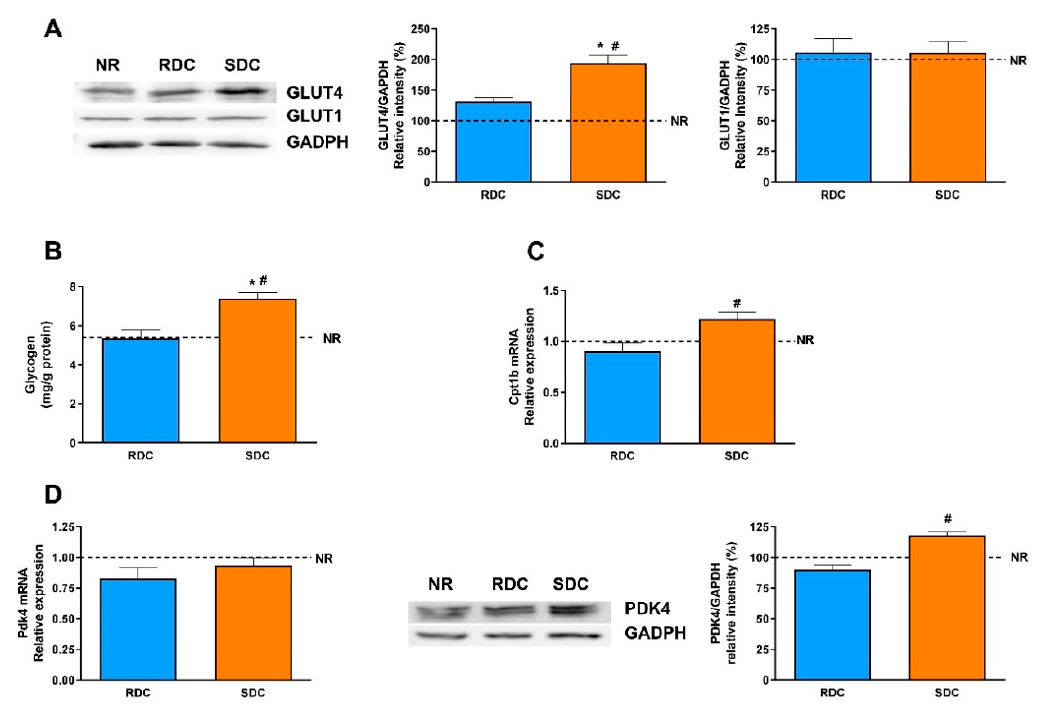
Figure 6. Muscle expression of key transporters and regulatory enzymes in the experimental groups. ( A ). Glucose transporters, ( B ) glycogen content, ( C ) Carnitine palmitoyl-transferase 1b (Cpt1b) mRNA expression. ( D ). Pyruvate dehydrogenase kinase 4 (PDK4) mRNA and protein expression. NR group, not restricted; RDC group, re-feeding with rapid digestible CHO diet; SDC group, re-feeding with slow digestible CHO diet. * Significant di ff erence with NR group, p < 0.05. # Significant di ff erence with RDC group, p < 0.05.